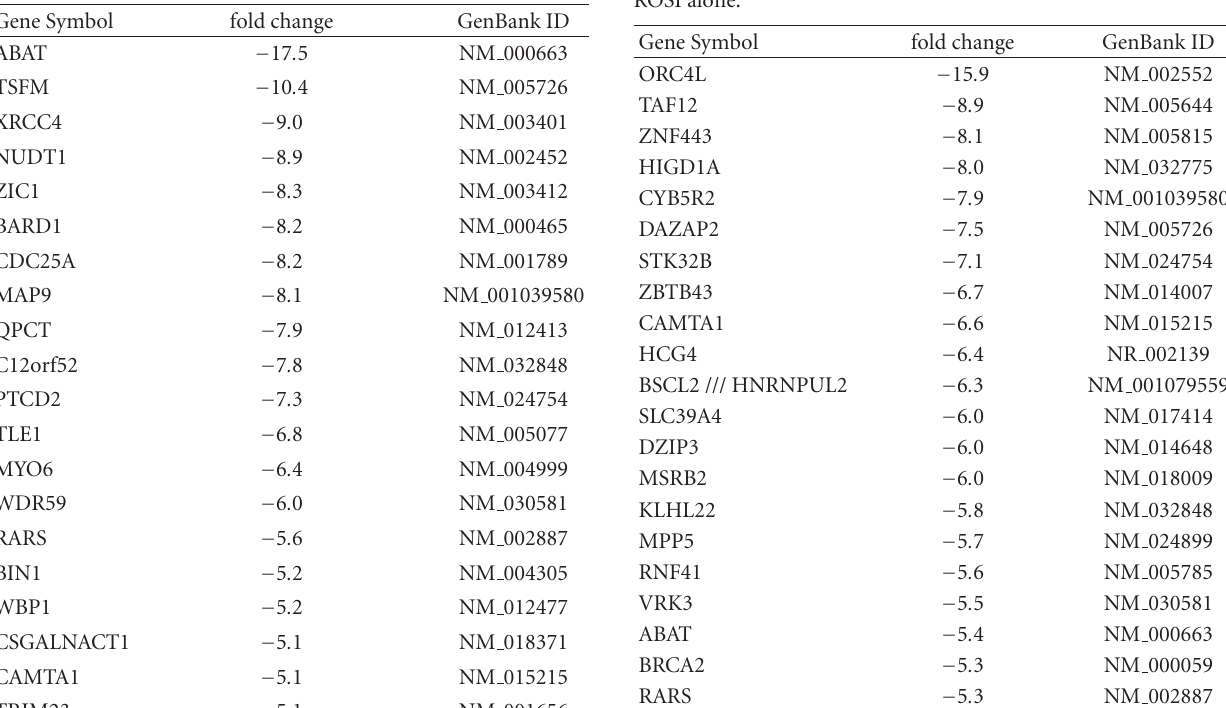
Table 2: Microarray Analysis of A375(DRO) cells after TZD/ rexinoid combination treatment—2-fold down regulated genes.